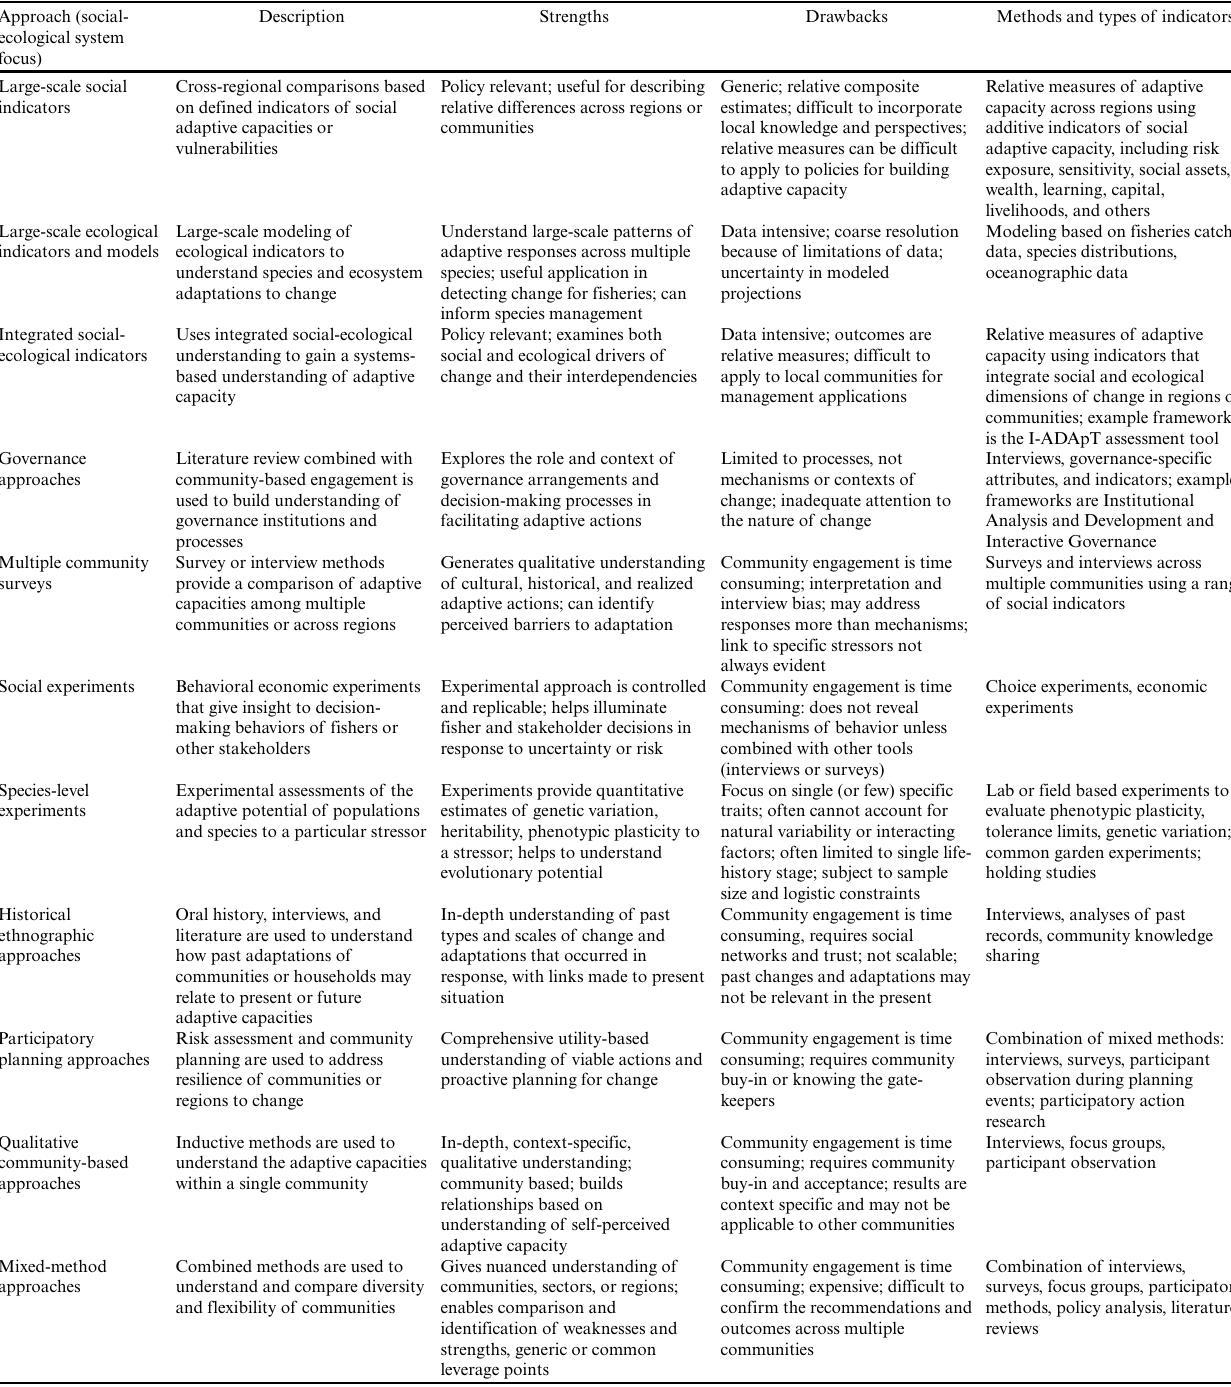
Table 1. Summary of approaches used to measure and assess adaptive capacity of social, ecological, and social-ecological systems. Assessment approaches are listed in order of typical spatial scale of application from largest to smallest. See Appendix 1 for a detailed description of these approaches with references to example empirical studies and